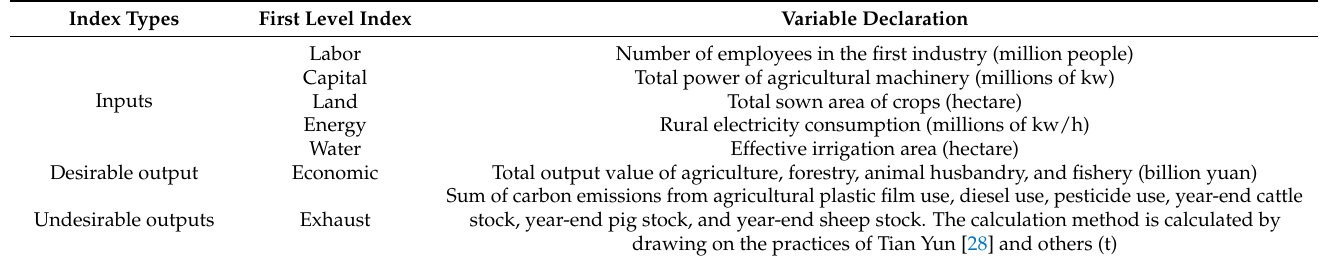
Table 1. Evaluation indexes of the contribution rate of GASTP.